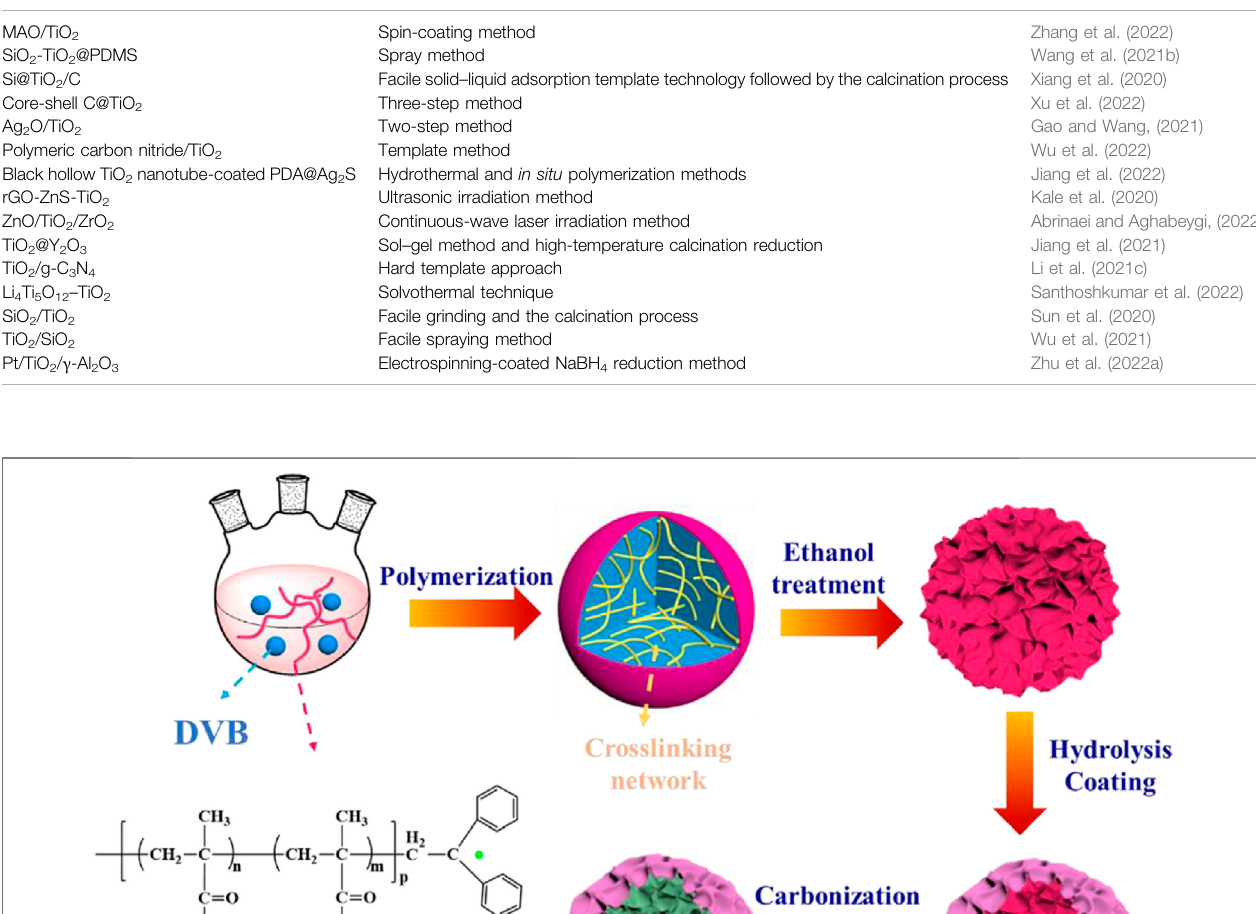
Frontiers in Materials |